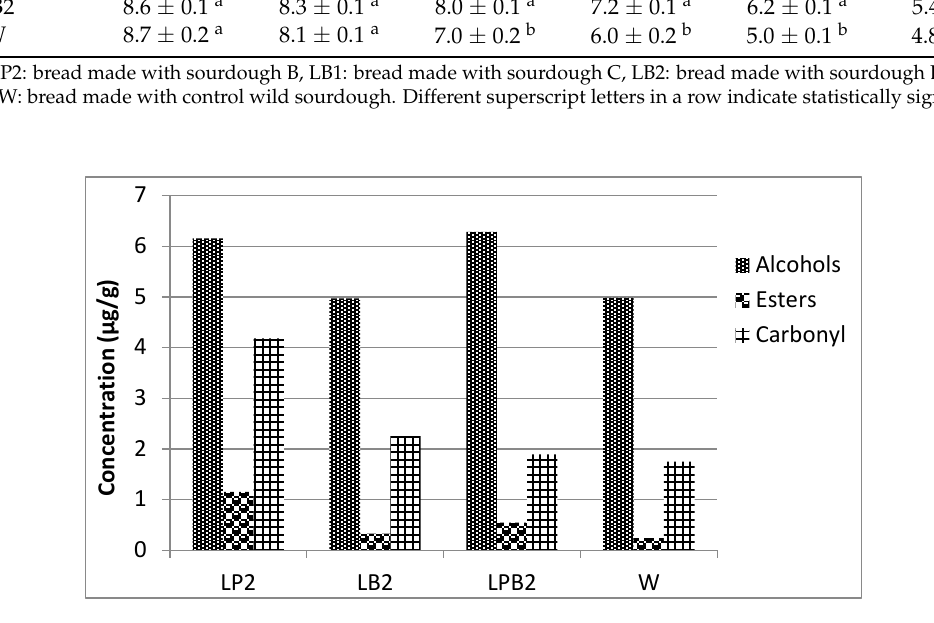
Figure 1. Concentrations (μg/g) of certain volatile chemical groups expressed as mean values in the sourdough bread samples.